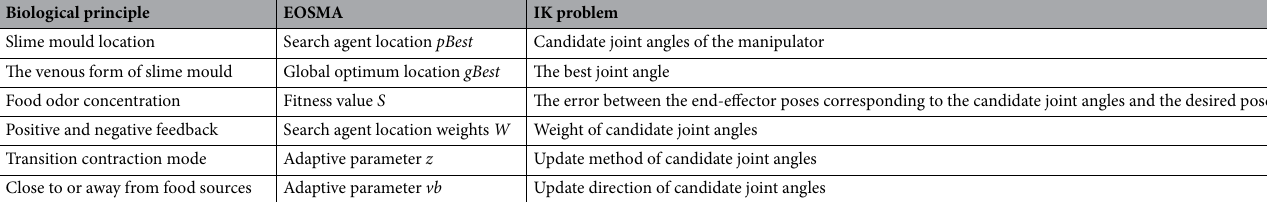
Table 2. The correspondence between EOSMA and IK